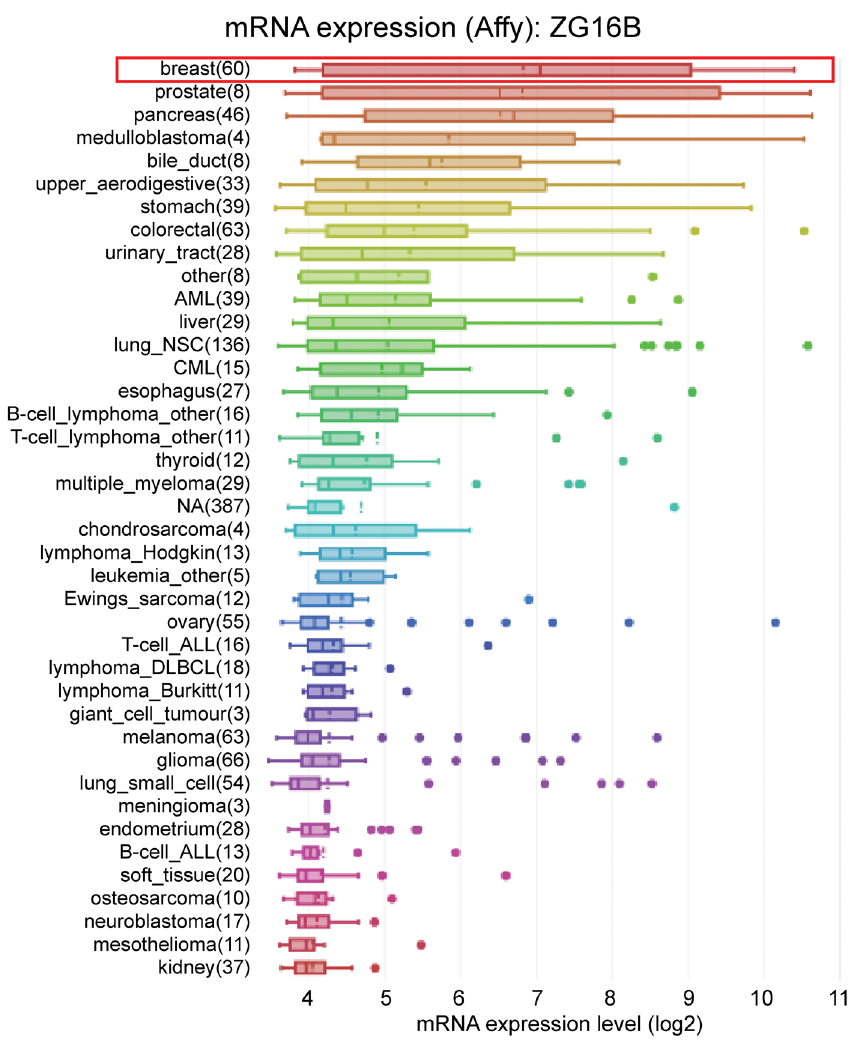
Figure 2: Analysis of ZG16B mRNA expression in cancer cells. ZG16B mRNA expression levels in 40 types of cancer cell lines were measured by A ff ymetrix gene chips and arranged from the highest to the lowest ( CCLE analysis ) . ZG16B mRNA expression level was the fi rst highest in breast cancer cells among all